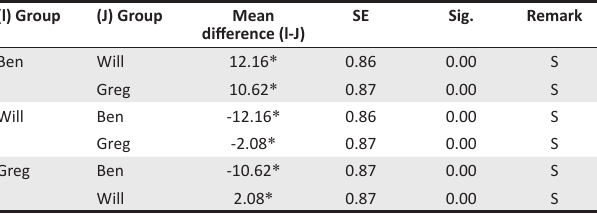
TABLE 3: Results of analysis of variance analysis of pairwise comparison of means (post hoc test). (l) Group (J) Group Mean SE difference (l-J)